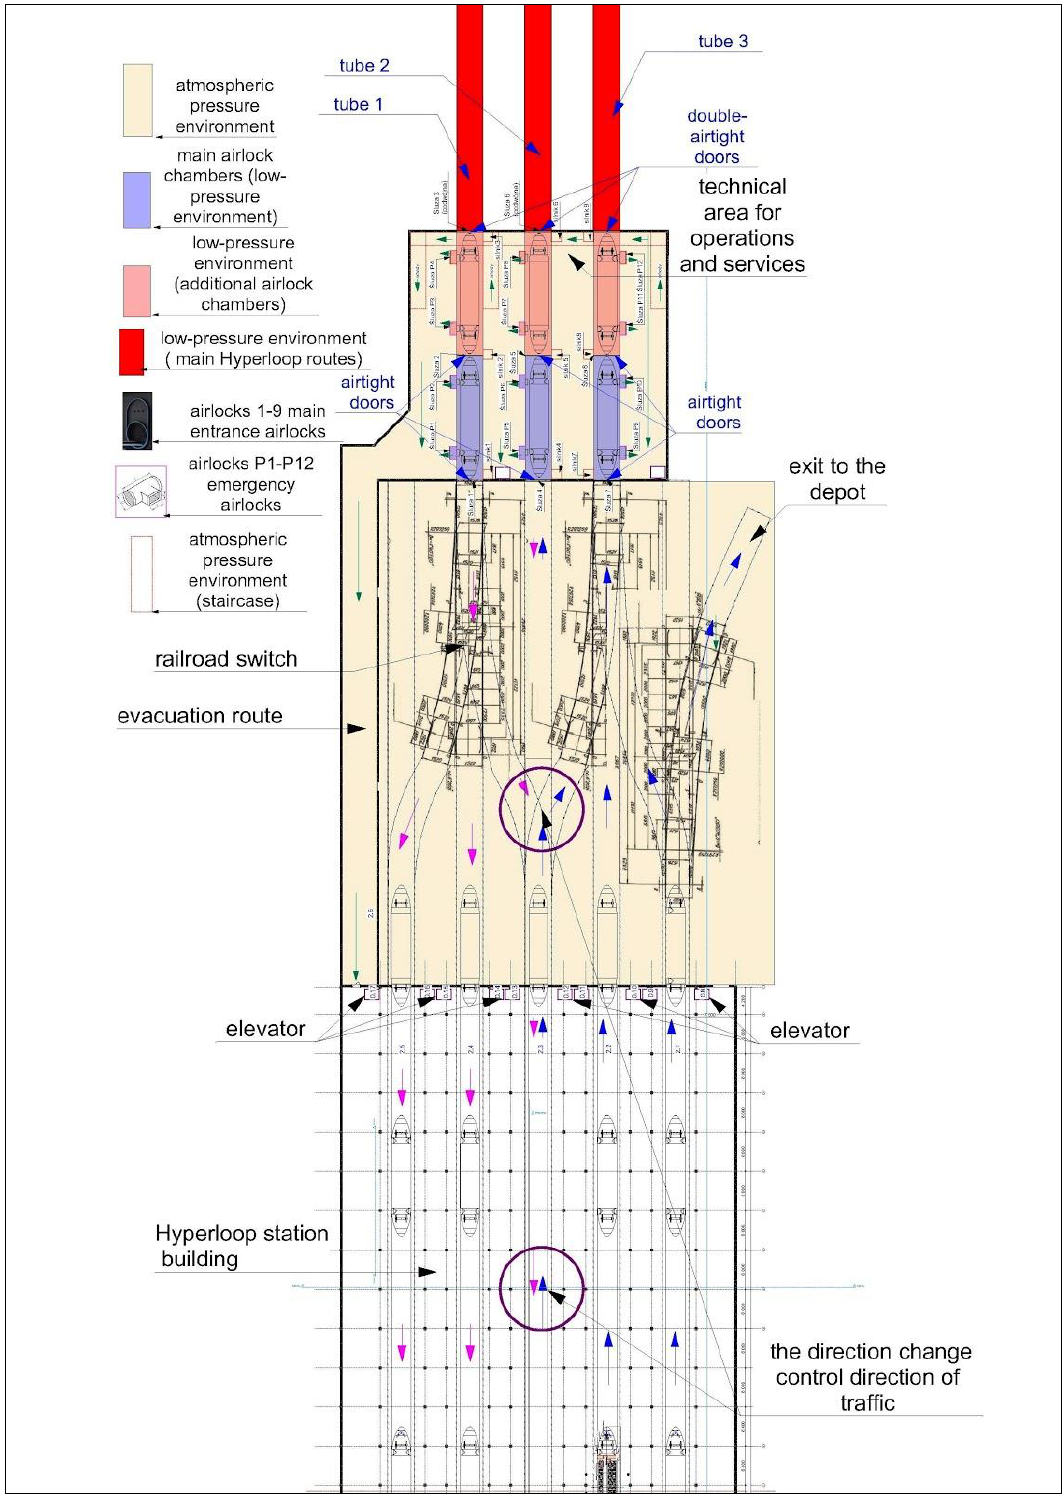
Figure 8. Fragment of turnouts in the technical zone.